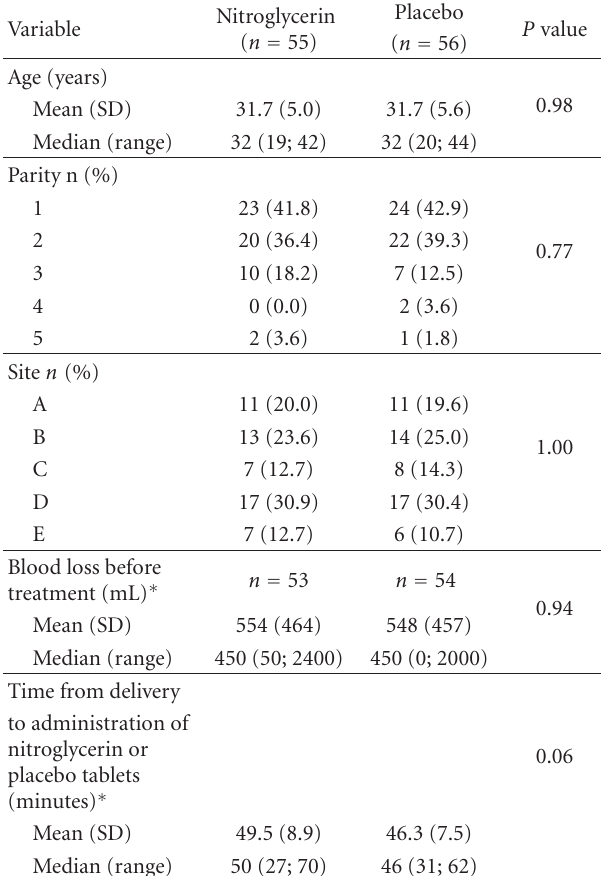
Table 1: Demographic and baseline characteristics (intention to treat group,